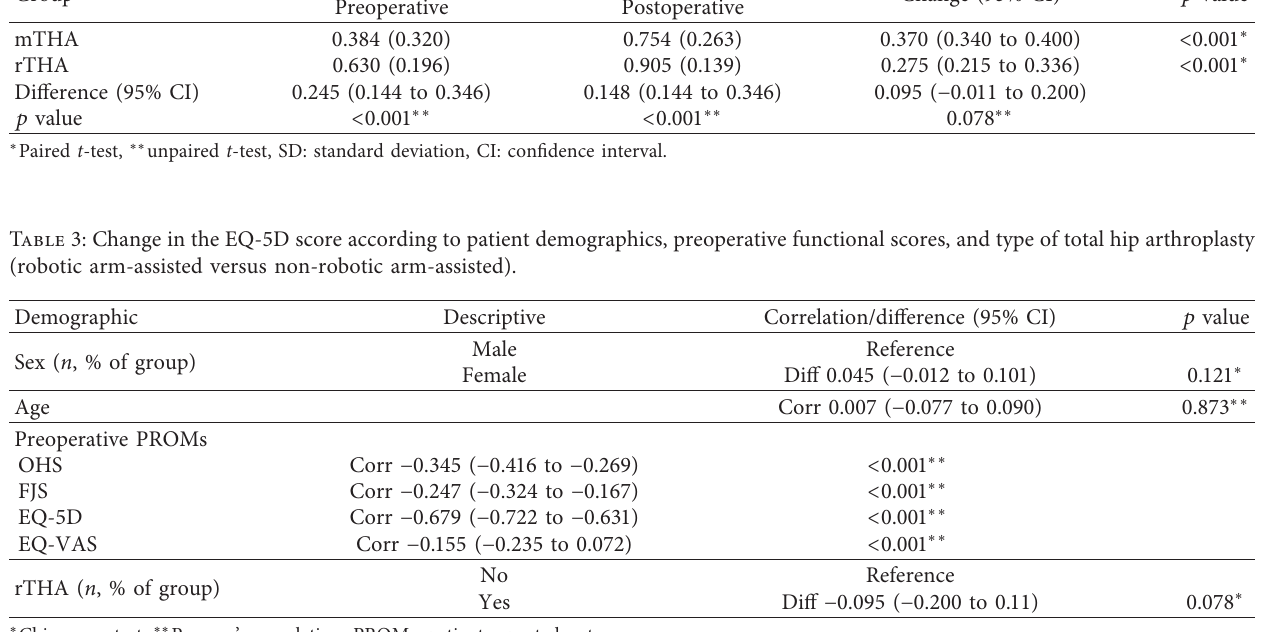
Table 4: Linear regression analysis of patient demographics, preoperative functional scores, and type of total hip arthroplasty (robotic arm- assisted versus non-robotic arm-assisted) associated with change in the EQ-5D score postoperatively.